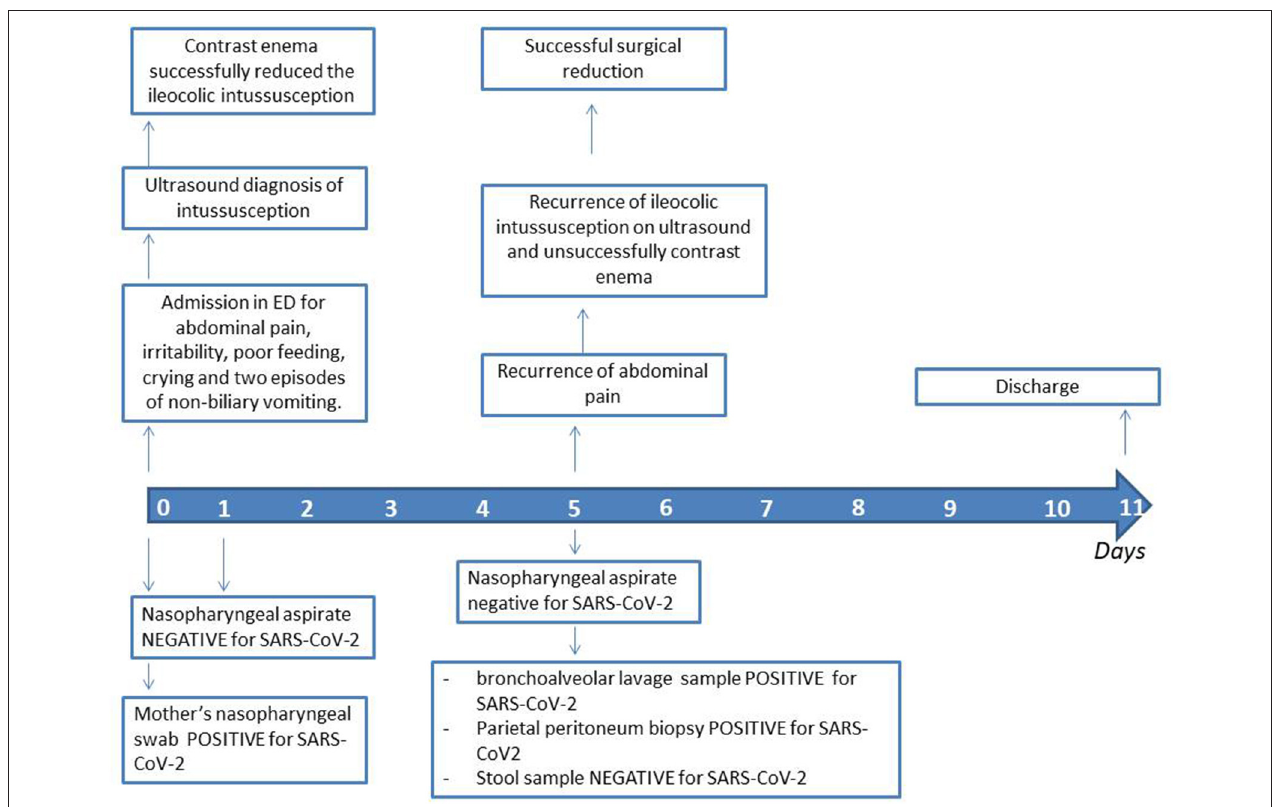
FIGURE 3 | Timeline course of the